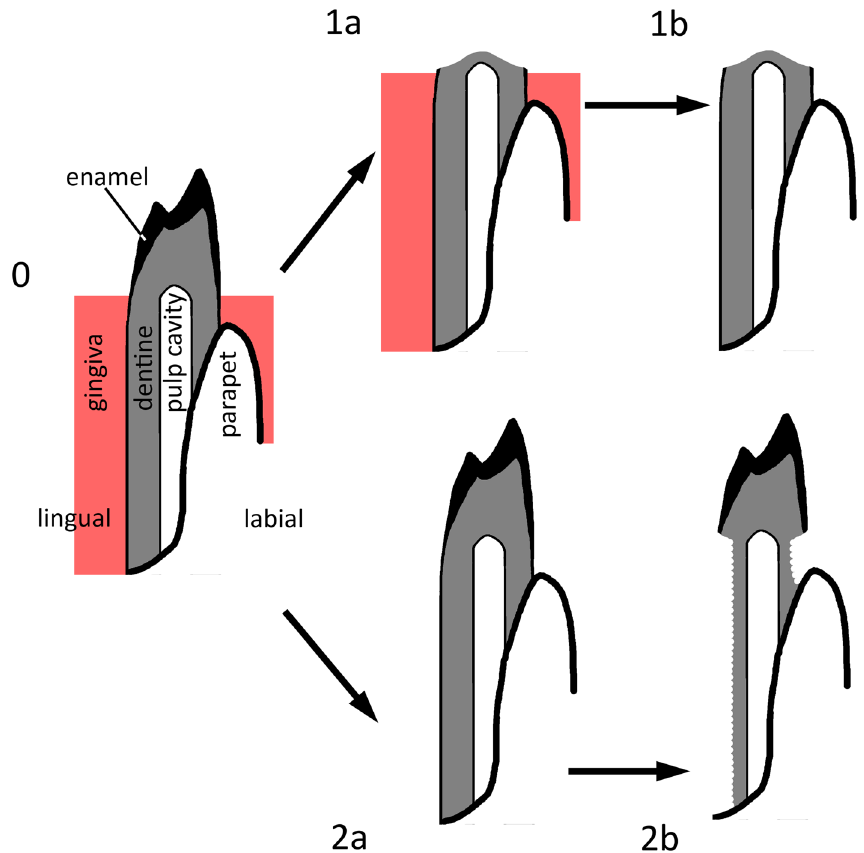
Figure 1. Cartoon depicting an idealized model of digestive corrosion on lizard teeth, shown here in transverse section. In the initial state (0), the crown, largely composed of enamel, is exposed, whereas the shaft, largely composed of dentine, is covered lingually by the gingiva and labially by bone (the parapet of the jaw). In the enteric digesters, the gingiva remains intact while the crown is attacked by hydrochloric acid ( 1a ); digestion of soft tissue then occurs in the intestine after corrosion has ceased ( 1b ). As a result, the crown of the tooth is destroyed while the shaft is undamaged; this is type 1 corrosion. In the gastric digesters, the gingiva is